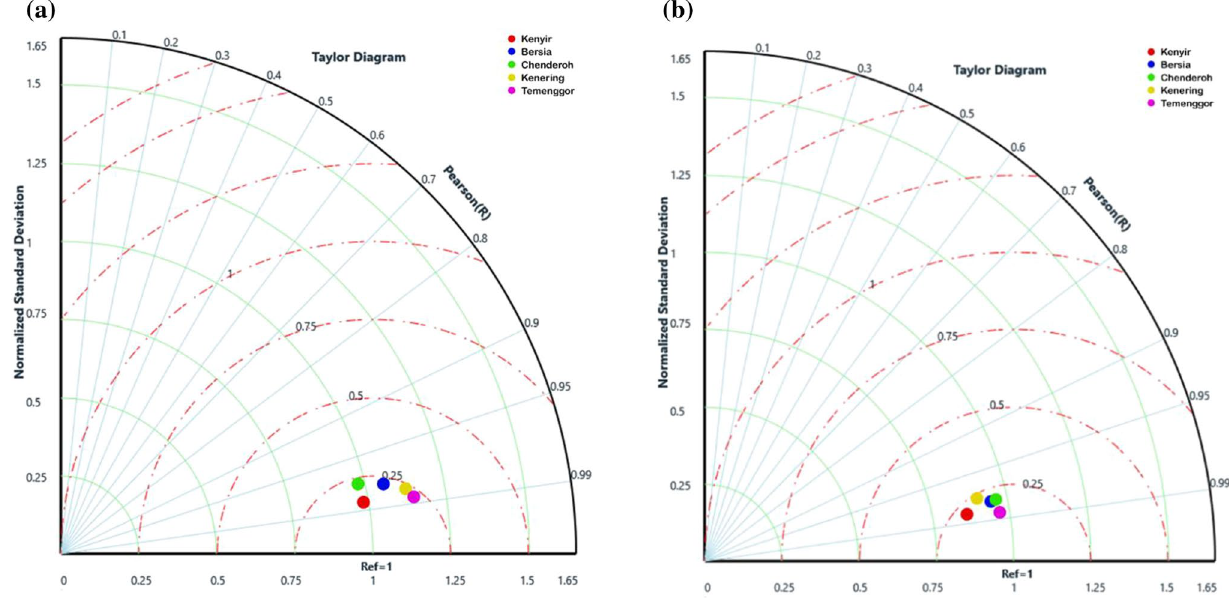
Fig. 9 Taylor diagram of hybrid BA-ANN at all five study areas: a training phase, b testing